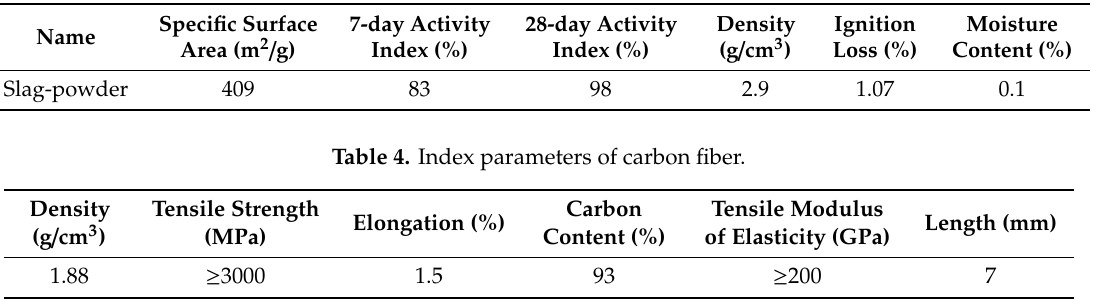
Table 3. Slag-powder index parameters.